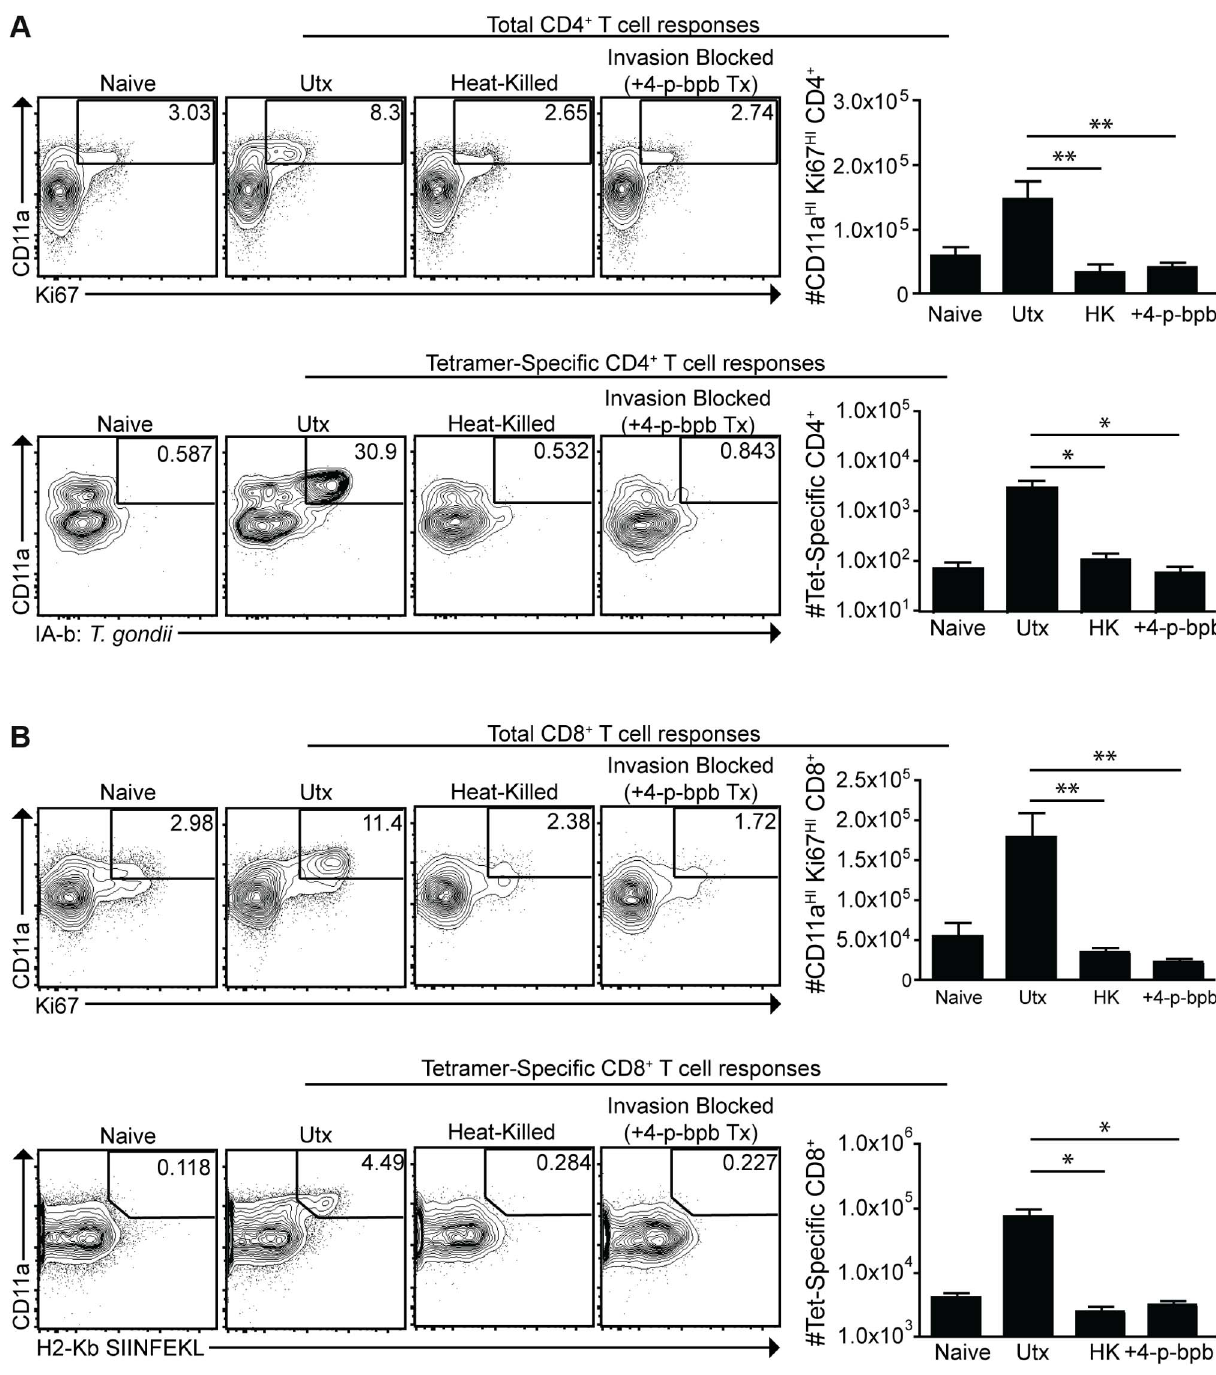
Figure 6. Active invasion is required for adaptive immune responses to T.gondii . cpsII -OVA parasites were heat-killed, treated with the invasion inhibitor 4-p-bpb or left untreated and administered to mice intraperitoneally. Tetramer-specific and total CD4 + (a) and CD8 + (b) T cell responses were measured from cells isolated from the spleen and lymph nodes (pooled) 10 days post-vaccination. Flow plots are gated on Foxp3 2 ve CD4 + T cells (a, top) or CD4 + T cells (a, bottom) and the population examined at the bottom of A was enriched for tetramer + ve cells. Flow plots in B are gated on CD8 + T cells. *p , 0.05; **p , 0.005. AVG 6 SE. were kept in specific-pathogen-free conditions at the School of Mice Veterinary Medicine at the University of Pennsylvania. For Flt3L 2 / 2 mice were obtained from Taconic Farms (German- experiments in which dendritic cells were depleted, CD11c-DTR town, NY). Batf3 2 / 2 mice, CCR2 2 / 2 and CD11c-DTR mice or WT control mice were administered 100 ng of Diphtheria were obtained from Jackson Laboratories. C57BL/6 mice were Toxin (Sigma-Aldrich) diluted in 100 m L of PBS (Invitrogen) obtained from Jackson Laboratories or Taconic Farms. All mice